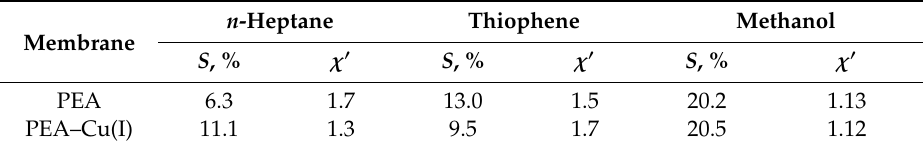
Table 5. Sorption degrees and interaction parameters, χ (cid:48) , for polymer membranes and components of liquid